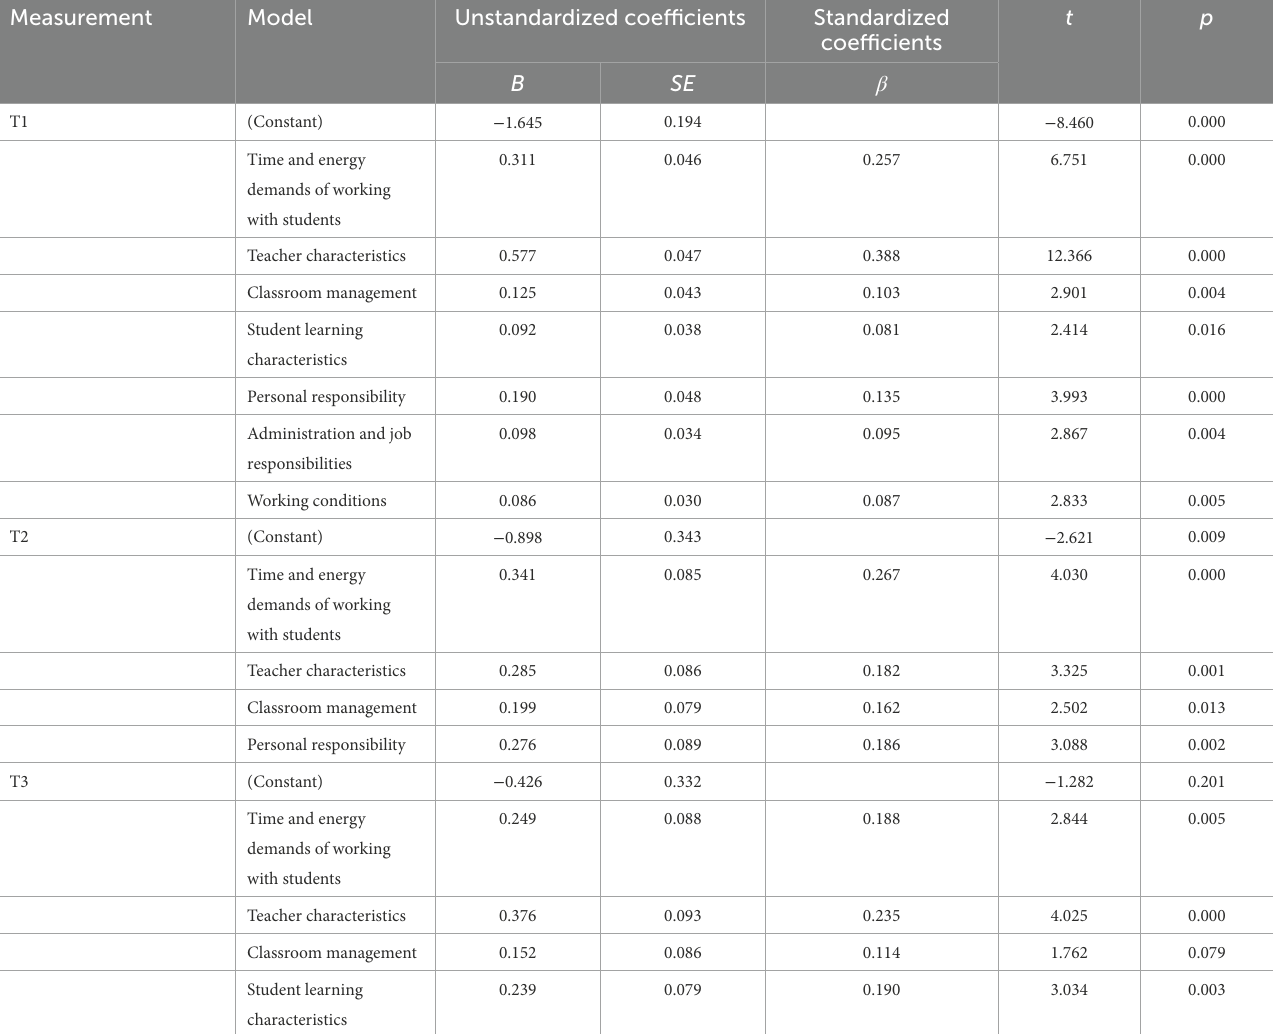
TABLE 12 Coefficients of categories of individual and environmental factors of burnout, model Forward .